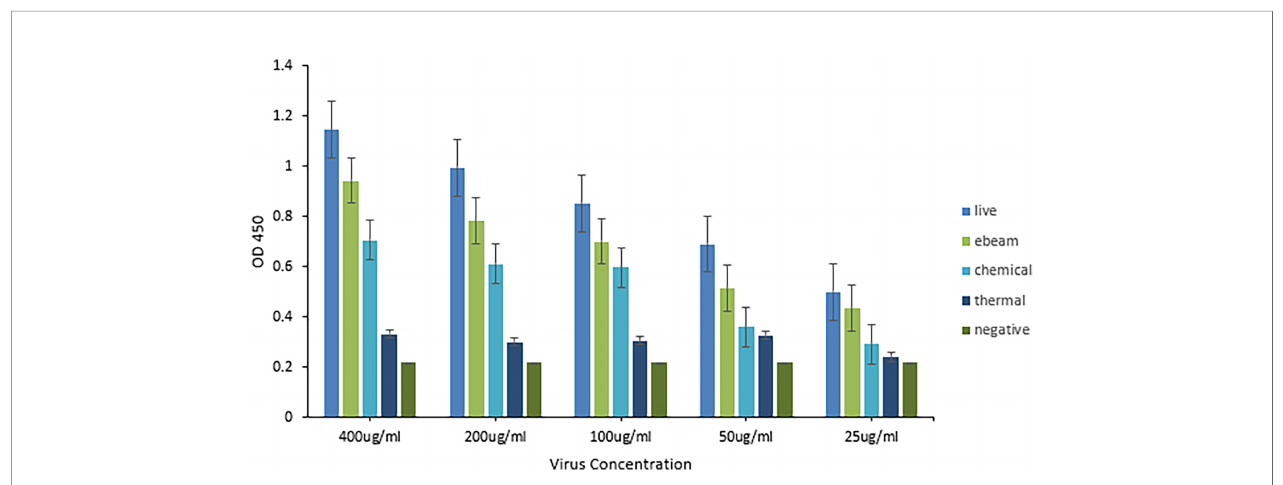
FIGURE 4 | Electron beam inactivation was superior in preserving antigenicity of HRV. Sandwich ELISA titration of inactivated HRV stocks to determine antigenicity. An ELISA plate was coated with puri fi ed chicken anti-HRV VP8 as the capture antibody and blocked with 5% gelatin in PBS. Four different HRV stocks including live virus, electron beam-inactivated virus, chemically inactivated virus, and thermally inactivated virus, were serially diluted starting with a 400µg/ml concentration. Biotinylated chicken anti-HRV VP8 served as the detection antibody (1:1,000) and HRP-conjugated neutravidin was used to detect (1:20,000). The eBeam inactivated virus was detected at ~75-90% that of non-irradiated live virus control. The chemical and thermal inactivated viruses were detected at ~50-60 and 25-40% that of the live virus, respectively. Compared to the live virus, antigenicity was best maintained after eBeam inactivation.